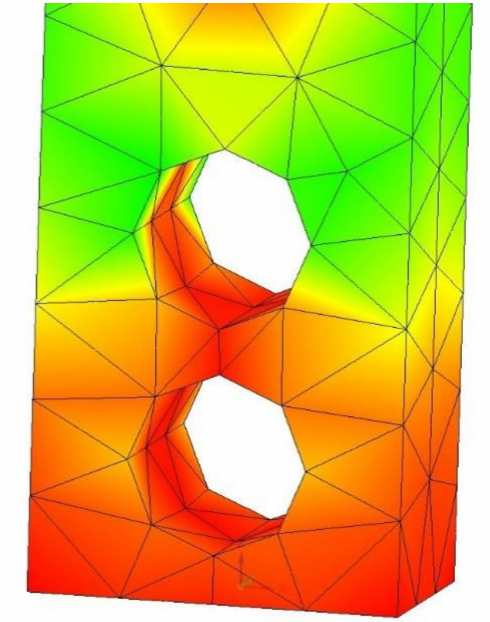
Figure 13. Stress concentrator on the surface of the mounting